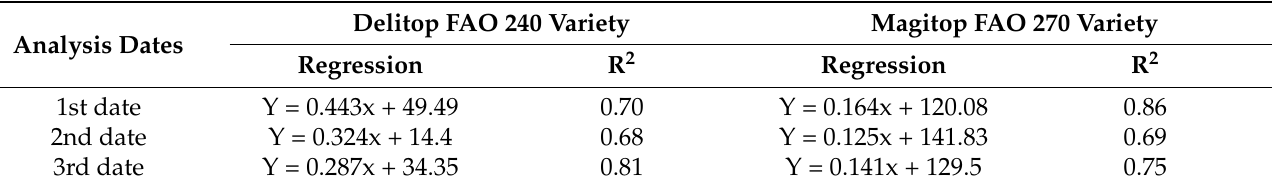
Table 6. Straight-line regression equations describing the relationship between SPAD values measured in successive time points and DMY of whole